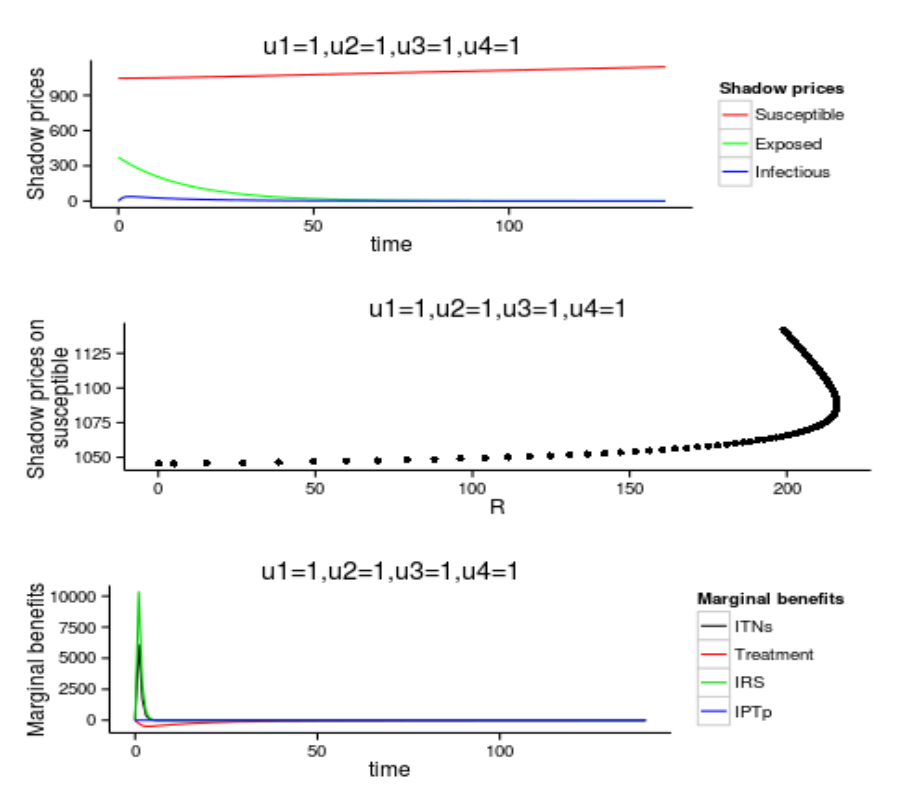
Figure 2. Numerical simulations of the economic evaluations of the malaria model for the endemic transmission settings.